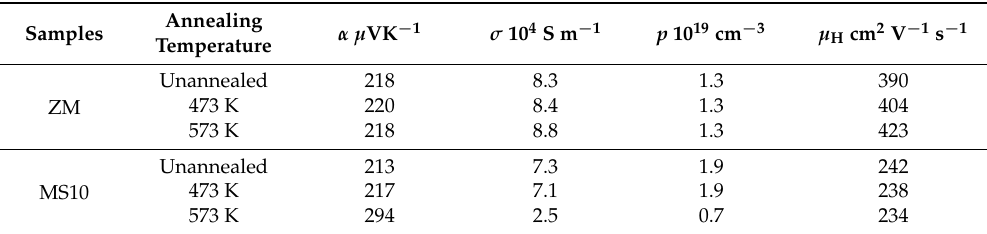
Table 1. The room temperature electrical transport properties of ZM and MS10 samples before and after annealing at 473 and 573 K, respectively.